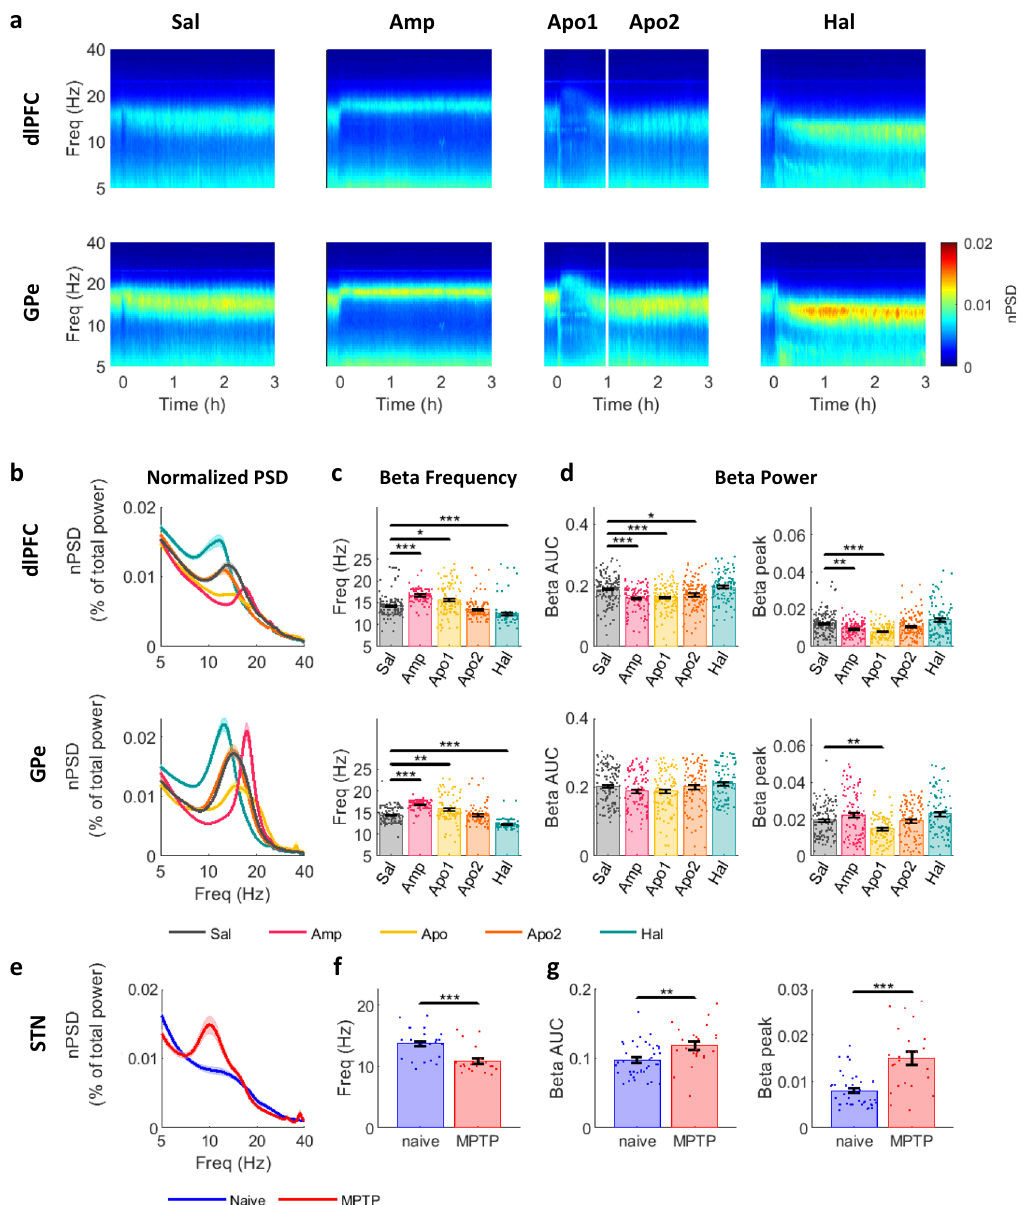
Fig. 2 Up- and down-modulation of dopamine tone up- and down-shifts LFP beta-frequency in NHP CBG circuit. a – d dlPFC and GPe LFP properties after acute dopamine modulation. a Average spectrogram of dlPFC and GPe LFP. Time 0 indicates injection time. Color scale indicates nPSD. White line divides the post-apomorphine period into Apo1 and Apo2 phases. b – d LFP beta properties in dlPFC and GPe b Average nPSD during drug in fl uence time (mean ± STE). c Frequency of LFP beta peaks (mean ± STE, N dlPFC = 527, N GPe = 491 LFP sites with detected beta-peak). Beta-frequency was modulated by dopaminergic drugs in the dlPFC ( p = 9.9e-9 a , 0.023, 1.6e-8 for Amp, Apo1 and Hal, respectively), and GPe ( p = 9.9e-9 a , 0.003, 9.9e-9 a for Amp, Apo1 and Hal, respectively). d Beta-power evaluated as area under the curve (AUC) of the nPSD, or as nPSD beta peak within 8 – 24 Hz range (mean ± STE, N = 611, N = 499 LFP sites). Beta AUC was modulated by dopaminergic drugs in the dlPFC ( p = 2.5e-6, 2.8e-5, 0.017 for Amp, Apo1 and Apo2, dlPFC GPe respectively). Beta-peak was modulated by dopaminergic drugs in the dlPFC ( p = 0.003, 1.1e-8, for Amp and Apo1, respectively), and GPe ( p = 0.003 for Apo1). c , d Single points indicate individual LFP sites. Outlier values were excluded from the fi gure, for presentation purposes. Outlier values were de fi ned as data points exceeding 8,5,5 standard deviations distance from the mean for frequency, AUC, and beta-peak, respectively. Drug in fl uence was evaluated by Kruskal – Wallis test followed by post-hoc Tukey test. e , f , g STN LFP properties after chronic MPTP dopamine lesion. Conventions same as b , c , d , respectively. Chronic MPTP modulated beta-frequency ( f ; N = 45; p = 1.1e-4) and beta power ( g ; N = 65; AUC: p = 1.1e-4, beta-peak: p = 7.3e-7) in the STN. Drug in fl uence was evaluated by two-sided student ’ s two-sample t -test. Test results can be found in Table-S4. Source data are provided as a Source Data fi le. * p < 0.05, ** p < 0.01, *** p < 0.001, a post-hoc p -value resolution was limited to 9.9e-9. LFP: local fi eld potential, NHP: non-human primate,